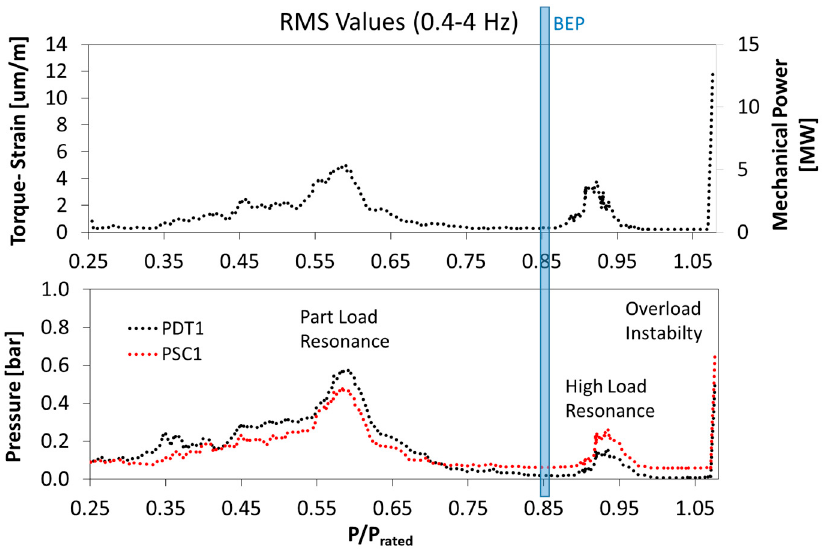
Figure 6. Root Mean Square (RMS) values of the pressure in the draft tube (PDT1) and spiral casing (PSC1) as well as the mechanical torque and power for the whole operating range of the turbine.